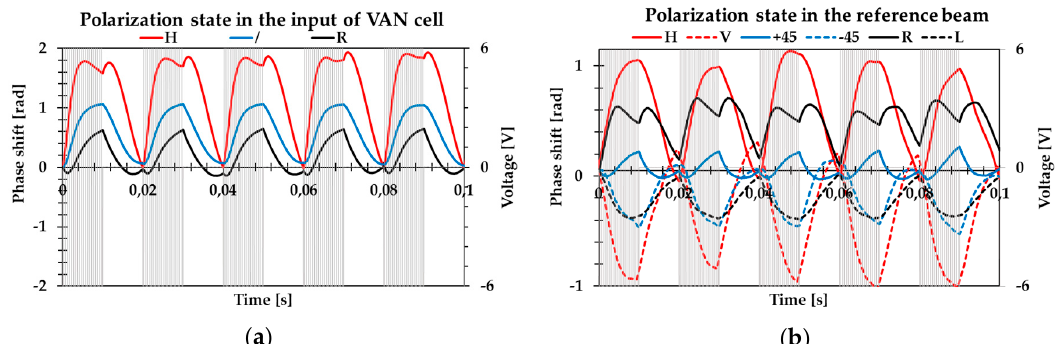
Figure 7. Real time phase shift measurements when the modulated waveform varied between zero and 6 V was applied to the vertically aligned nematic (VAN) cell. ( a ) Arbitrary polarization state in the input of the depolarizer while the reference beam is kept linearly polarized. ( b ) Horizontal polarization input while the reference beam polarization has been changed to horizontal (H), vertical (V), linear ±45°(+45 and − 45), circular left (L), and circular right (R).